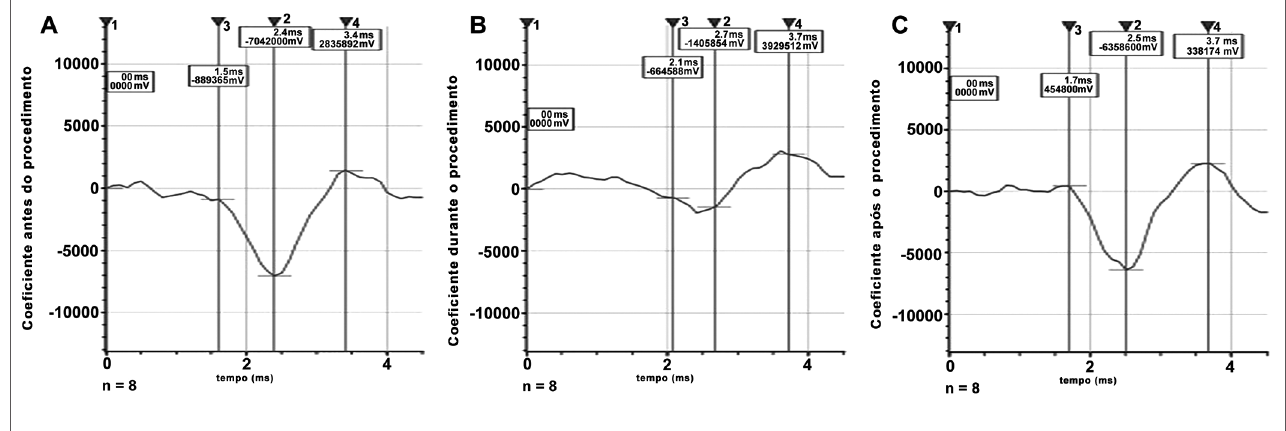
Figura 3. Valores médios dos potenciais evocados cocleares antes (A), durante (B) e depois (C) do procedimento.